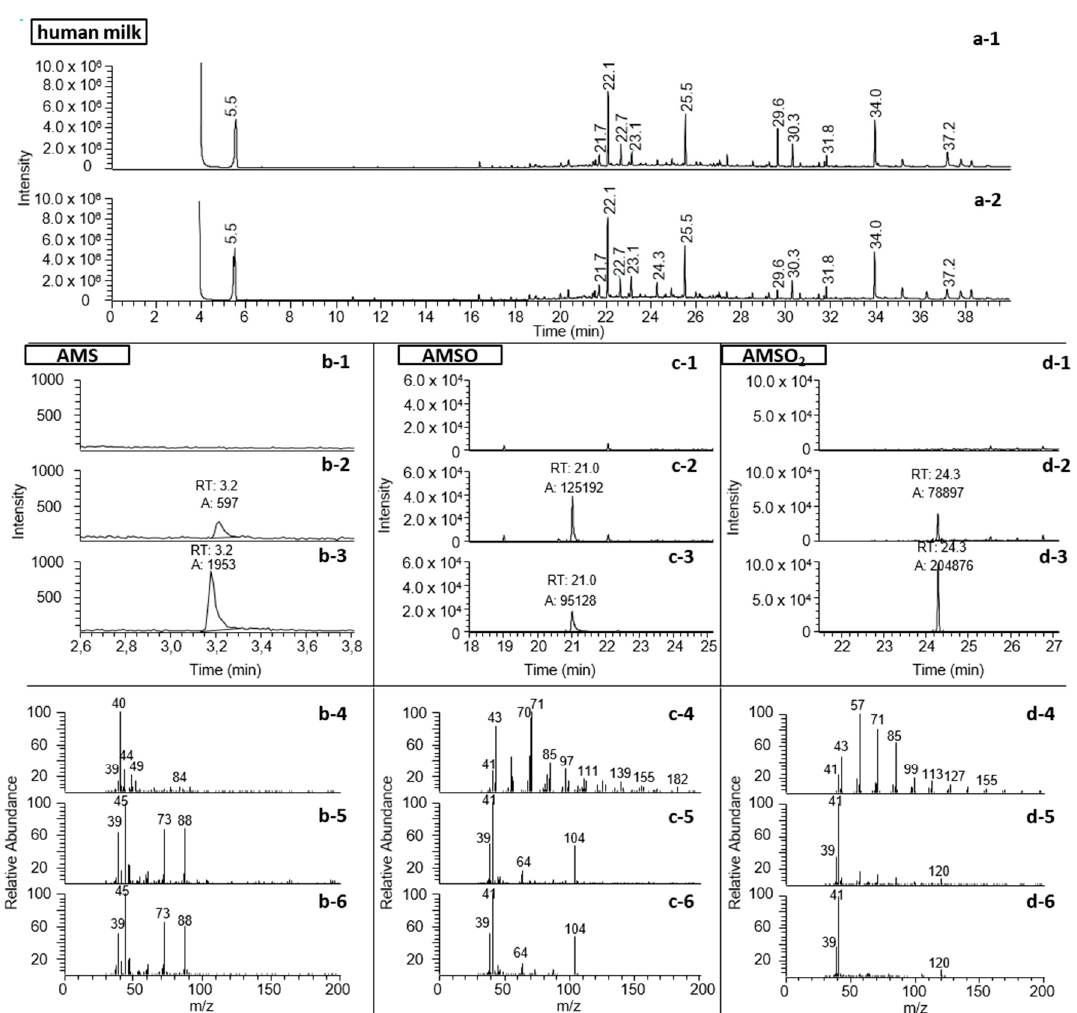
Figure 2. Identification and relative quantification of garlic-derived components in human milk samples of test person c . ( a ): Total ion chromatogram of human milk extract from HRGC-MS analysis (FFAP); ( b ): AMS, measured with HRGC-GC-MS; m / z 73 and 88 are extracted for relative quantification; ( c ): AMSO, measured with HRGC-MS (FFAP); m / z 104 is extracted for relative quantification; ( d ): AMSO 2 , measured with HRGC-MS (FFAP); m / z 120 is extracted for relative quantification. The human milk extract is shown 5 min before (a-1) and 3 h after (b-1) garlic ingestion. The compounds AMS, AMSO and AMSO 2 are shown in human milk 5 min before (x-1) and 3 h after (x-2) garlic ingestion as well as the standard compound (x-3), which was used for identification. In x-4 to x-6 the respective mass spectra to x-1 to x-3 are shown. The mass spectra are shown at the time when the standard compound eluted.